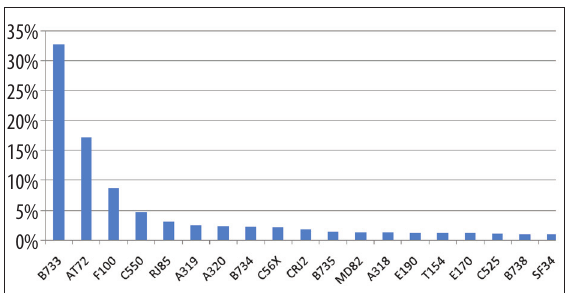
Fig. 4. Different aircraft types in total traffic (average summer day 2009, only IFR operations)